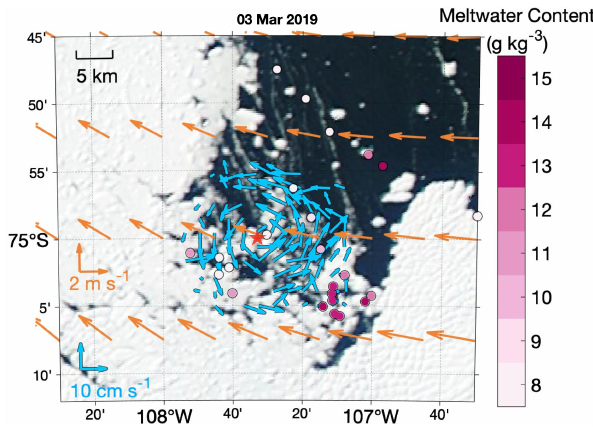
Figure 2. Map of the Thwaites gyre region. The blue arrows indi- cate the depth-averaged (30–430m) current velocity from sADCP measurements (observations are averaged to 2km × 2km bins; see blue scale vectors). The red star indicates the gyre centre. The or- ange arrows indicate the 2009–2019 climatological wind from the ERA5 reanalysis (Hersbach et al., 2018) (0 . 25 ◦ × 0 . 25 ◦ resolution; for clarity, velocity data are interpolated to 0 . 25 ◦ × 0 . 125 ◦ resolu- tion; see orange scale vectors). The pink shaded dots show the full- depth-averaged meltwater content calculated from ship-based CTD data (see colour